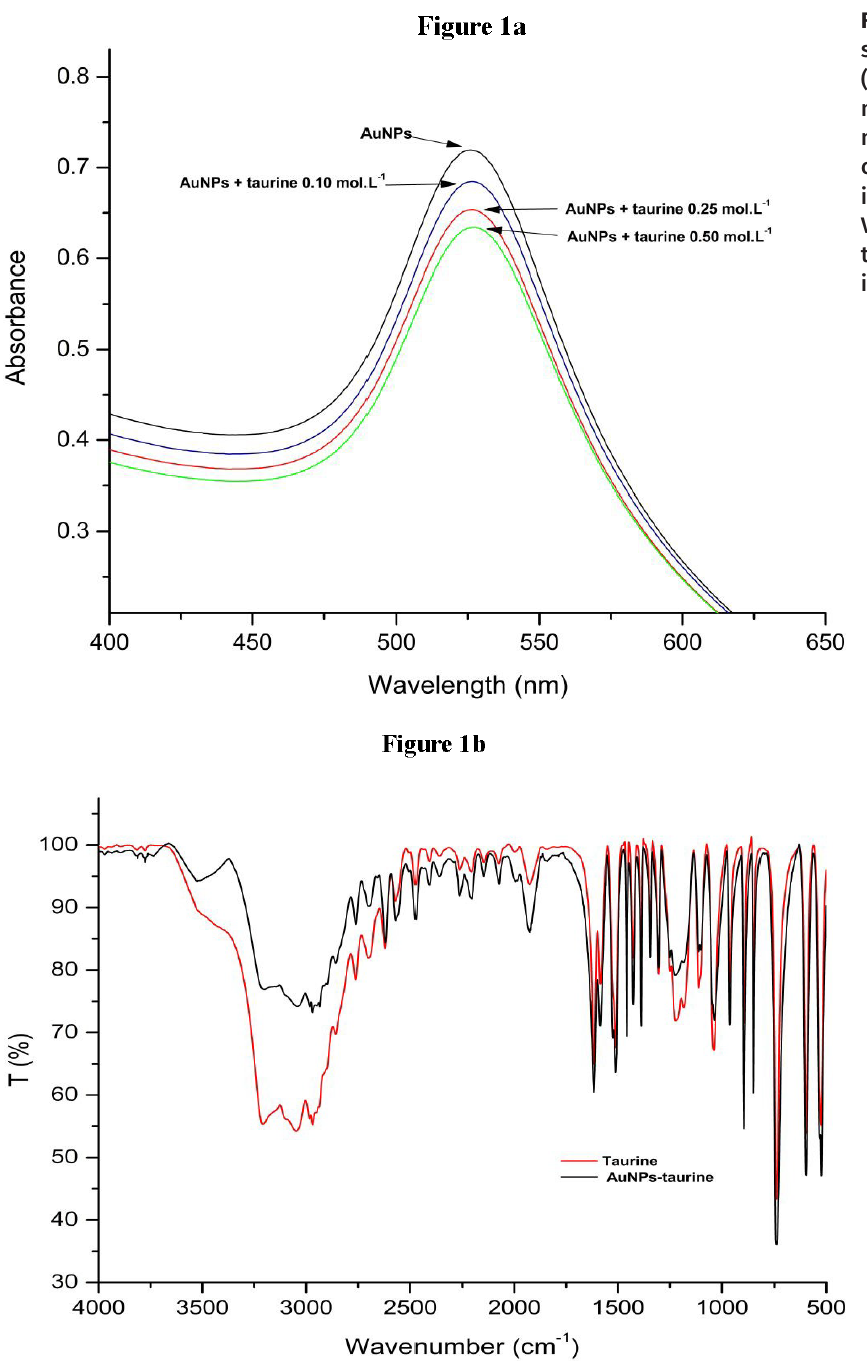
Figure 1. Represents the surface plasmon resonant (SPR) (a) band with maximum absorption at 525 nm. Addition of different concentration tau did not influence the SPR band. Vibrational spectra of tau and tau-AuNPs obtained by FT-IR in the ATR mode